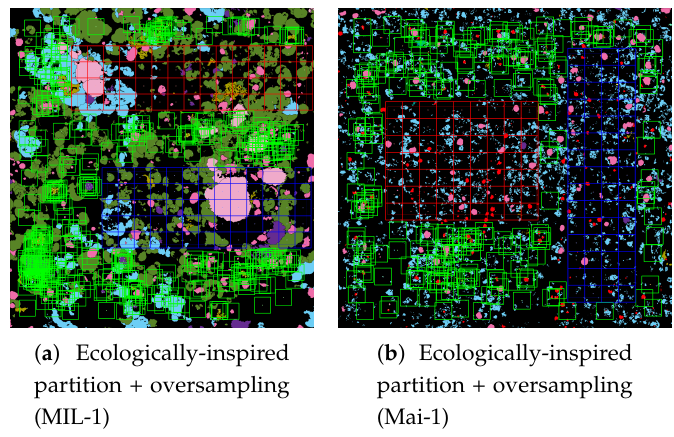
Figure 9. Oversampled tiles. ( a ) Ecologically inspired partition with oversampled training set on MIL-1. ( b ) Ecologically inspired partition with oversampled training set on MAI-1. Samples placed on the small-size corals incorporate a large amount of background pixels, preventing a good balancing of the